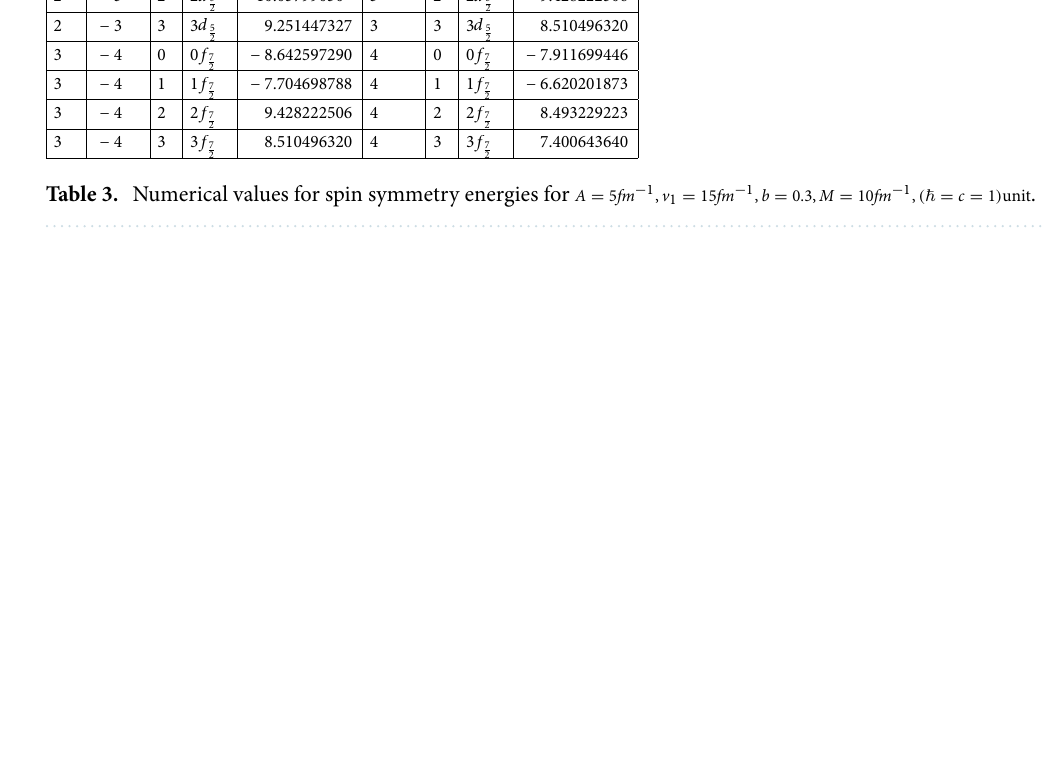
Table 3. Numerical values for spin symmetry energies for A